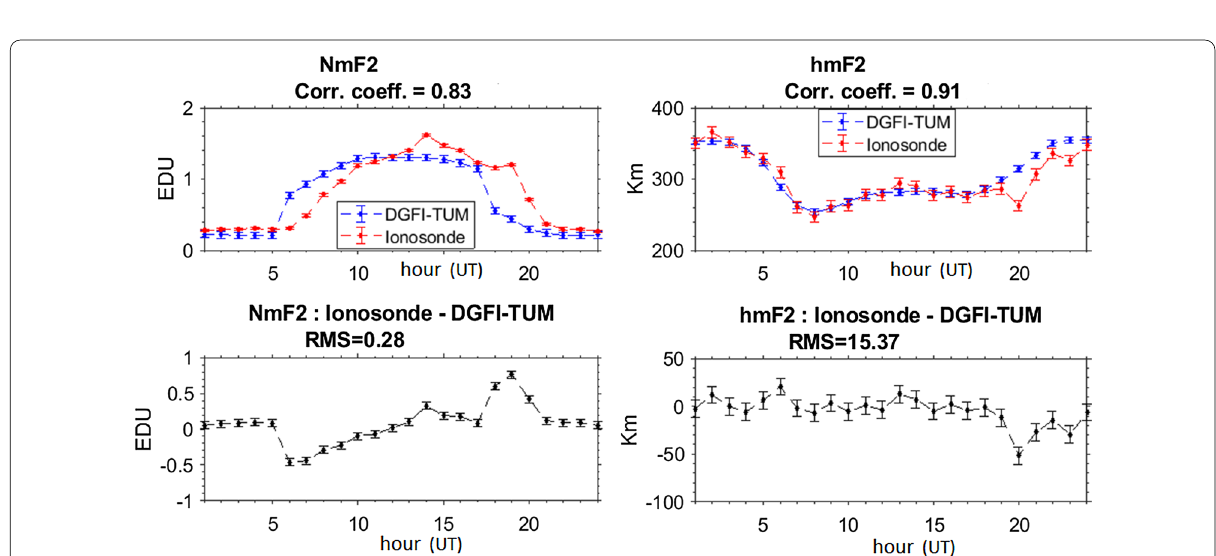
h F 2 m (top right panel) with the ionosonde data for the station EB040 at N F 2 m (top left panel) and (cid:31) (cid:31)